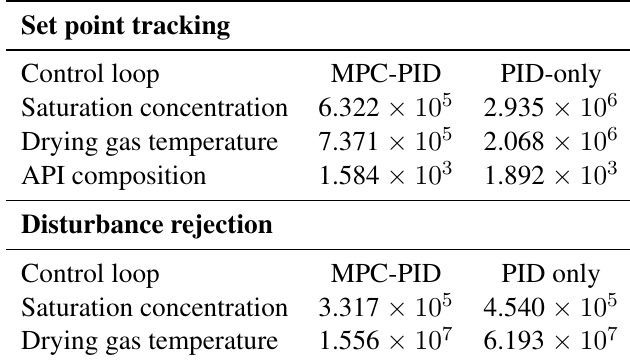
Table 3. List of integral time averaged error (ITAE) values for the MPC vs. PID performance